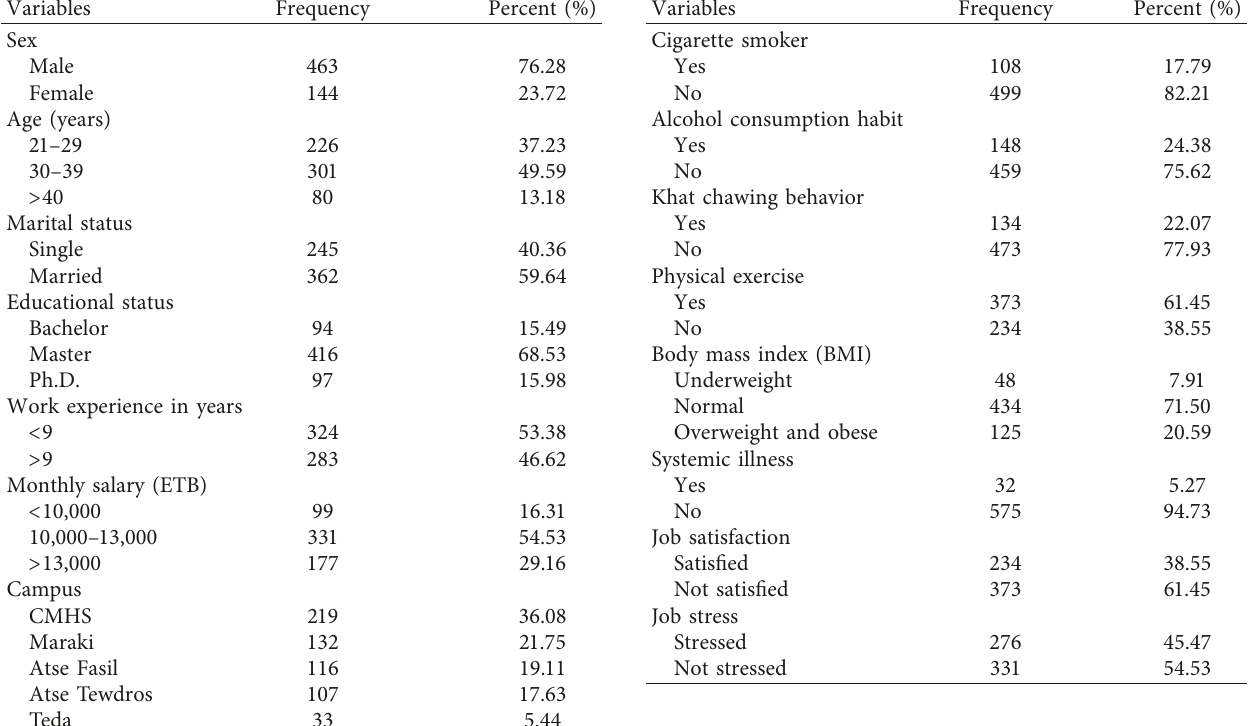
Table 3: Work environment and ergonomics characteristics